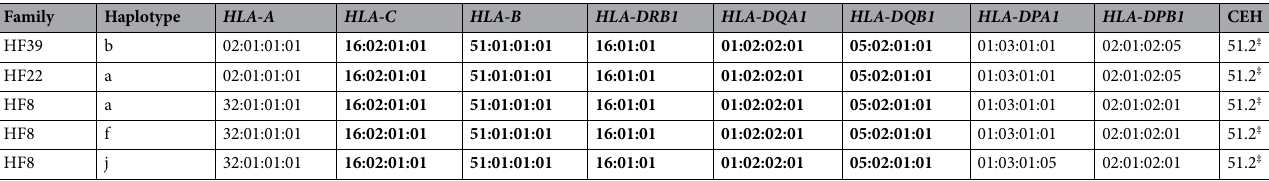
Table 9. MHC haplotypes of UAE families selected on the basis of HLA-B*51:01 . The group of alleles that make up the designated CEH in column “CEH” are denoted in bold. ‡ Proposed .